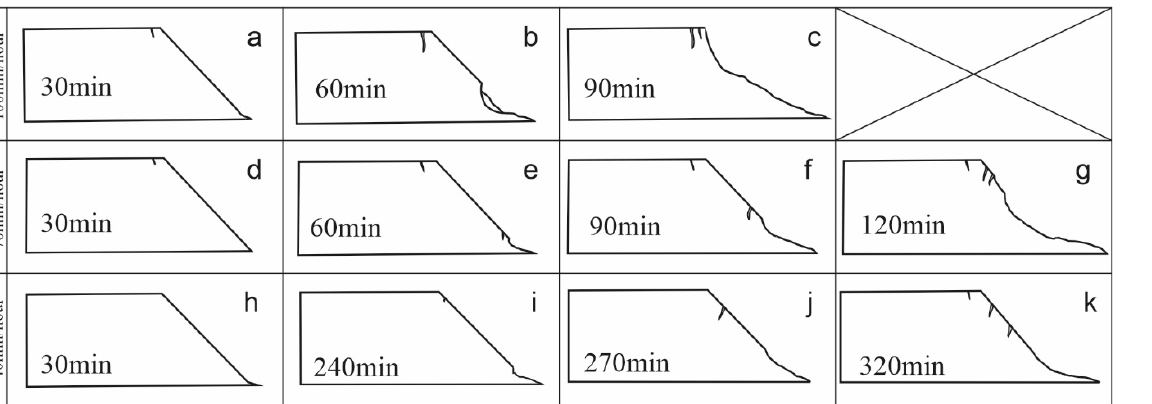
Figure 5. Slope failure pa tt erns associated with di ff erent rainfall intensities: 100 mm/h ( a , b , c ), 70 mm/h ( d , e , f , g ) and 40 mm/h ( h , i , j , k ). Explanation is provided in the text.